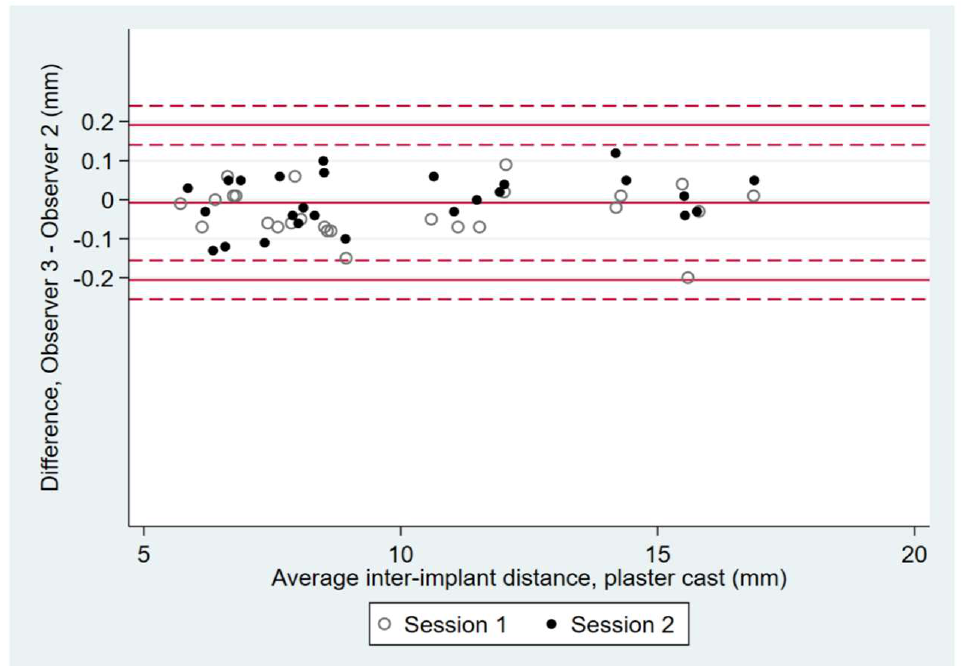
Figure 2. Bland–Altman diagrams show inter-observer reproducibility coefficients and 95% limits of agreement for observers 1 and 2 on CBCT axial and sagittal views, and for observers 2 and 3 on plaster casts. The inter-implant distances ranged from 5.6 mm to 17.1 mm. The representation of the mean difference (middle solid line), the confidence interval limits for mean (upper and lower solid lines) and the 95% agreement limits (dotted lines) are shown on the diagrams.